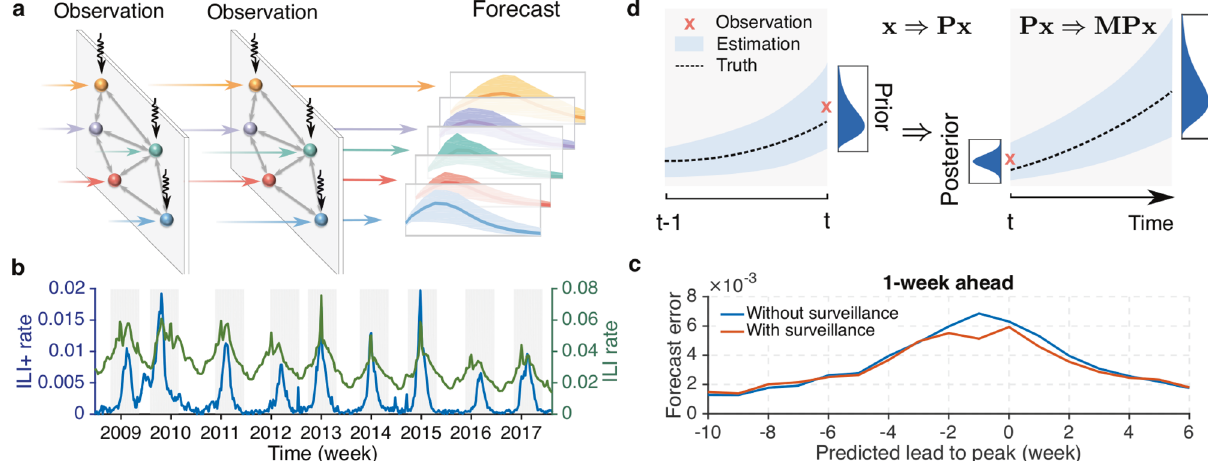
Fig. 1 The networked forecasting system and uncertainty propagation. a Schematic illustration of the networked forecasting system. At each observation time point, incidence data from 3 locations (vertical arrows) are used to adjust the dynamical model consisting of 5 connected locations. The adjusted model is then evolved forward (horizontal arrows) to the next observation time point, and ultimately further into the future to generate a forecast. ( b ) The national ILI + rate (blue line) and ILI rate (green line) for the 2008 – 2009 to 2016 – 2017 seasons from AFHSB data. Shaded areas indicate the retrospective forecasting periods. ( c ) Comparison of forecast error (mean absolute error) for 1-week ahead prediction with (red line) and without (blue line) surveillance data. The forecast error at each predicted lead (negative/positive: before/after predicted peak) was averaged over all 35 locations for versions with and without surveillance data. ( d ) Uncertainty propagation in the networked forecasting system. At time t , the prior state is updated to a posterior using available observations (red cross), which constrains the model toward the truth (dash line). The reduction of uncertainty x due to data assimilation and its growth during model integration can be approximated by x ⇒ Px and Px ⇒ MPx .